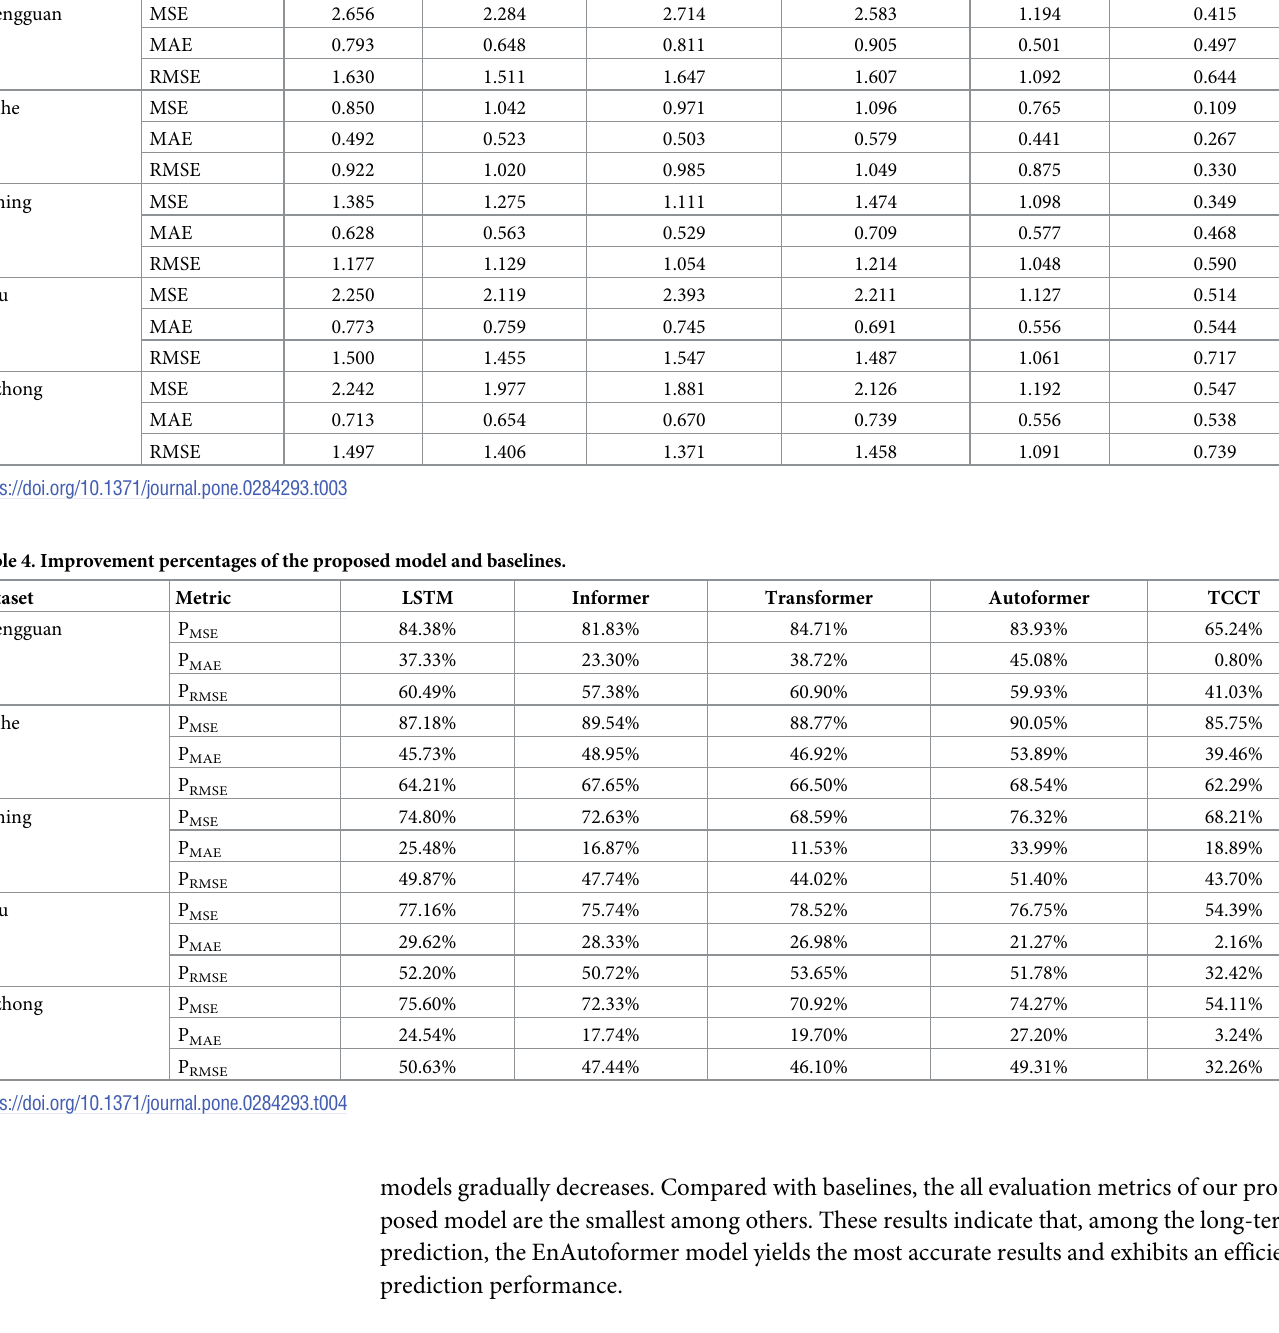
Table 3. Performance comparison of the proposed model and baselines. Dataset